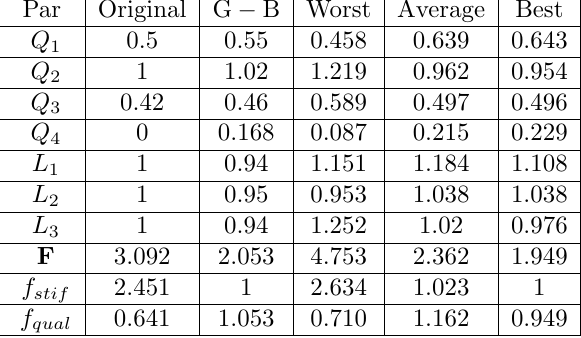
Figure 30: The convergence trend of the main objective function F as a summary of 3 sub-objectives ( f qual , f stif and f g ) in 500 iterations. Table 4: Comparison of the design optimisation re- sults.